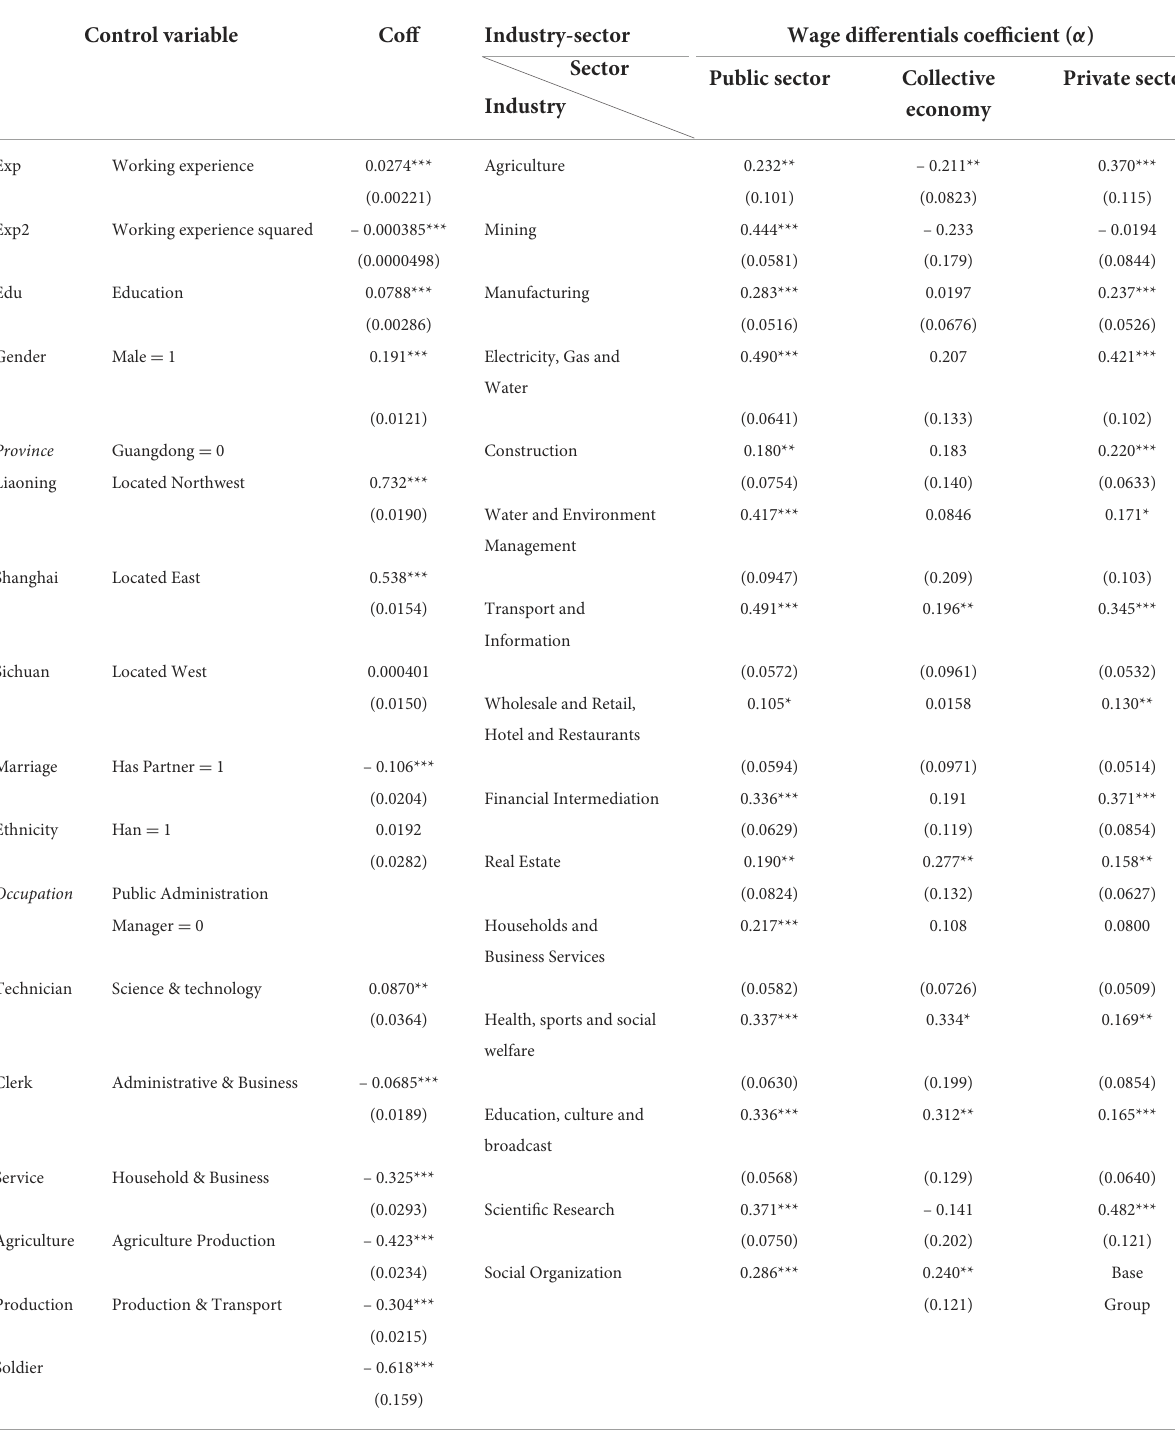
TABLE 2 First-stage estimation for